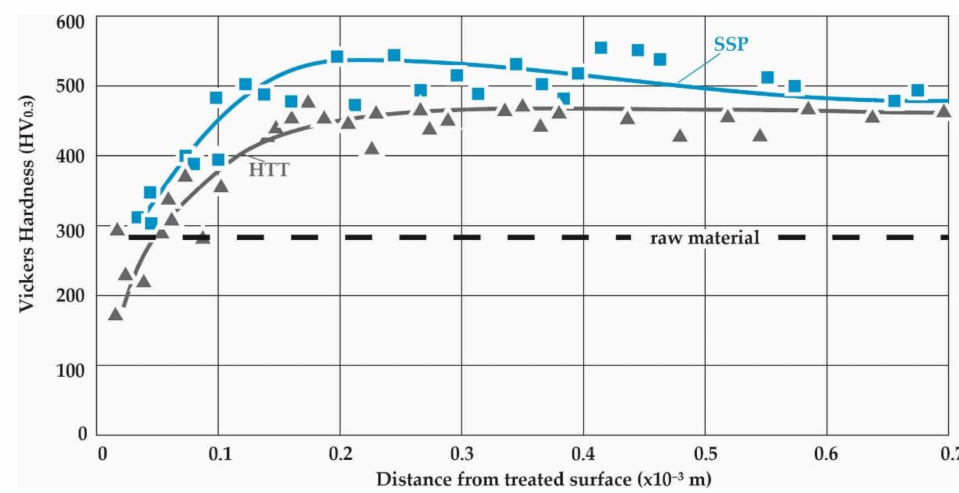
Figure 7. Vickers micro-hardness measurements, average distributions and scattering of results on the HTT and HTT+SSP specimens along the distance from the